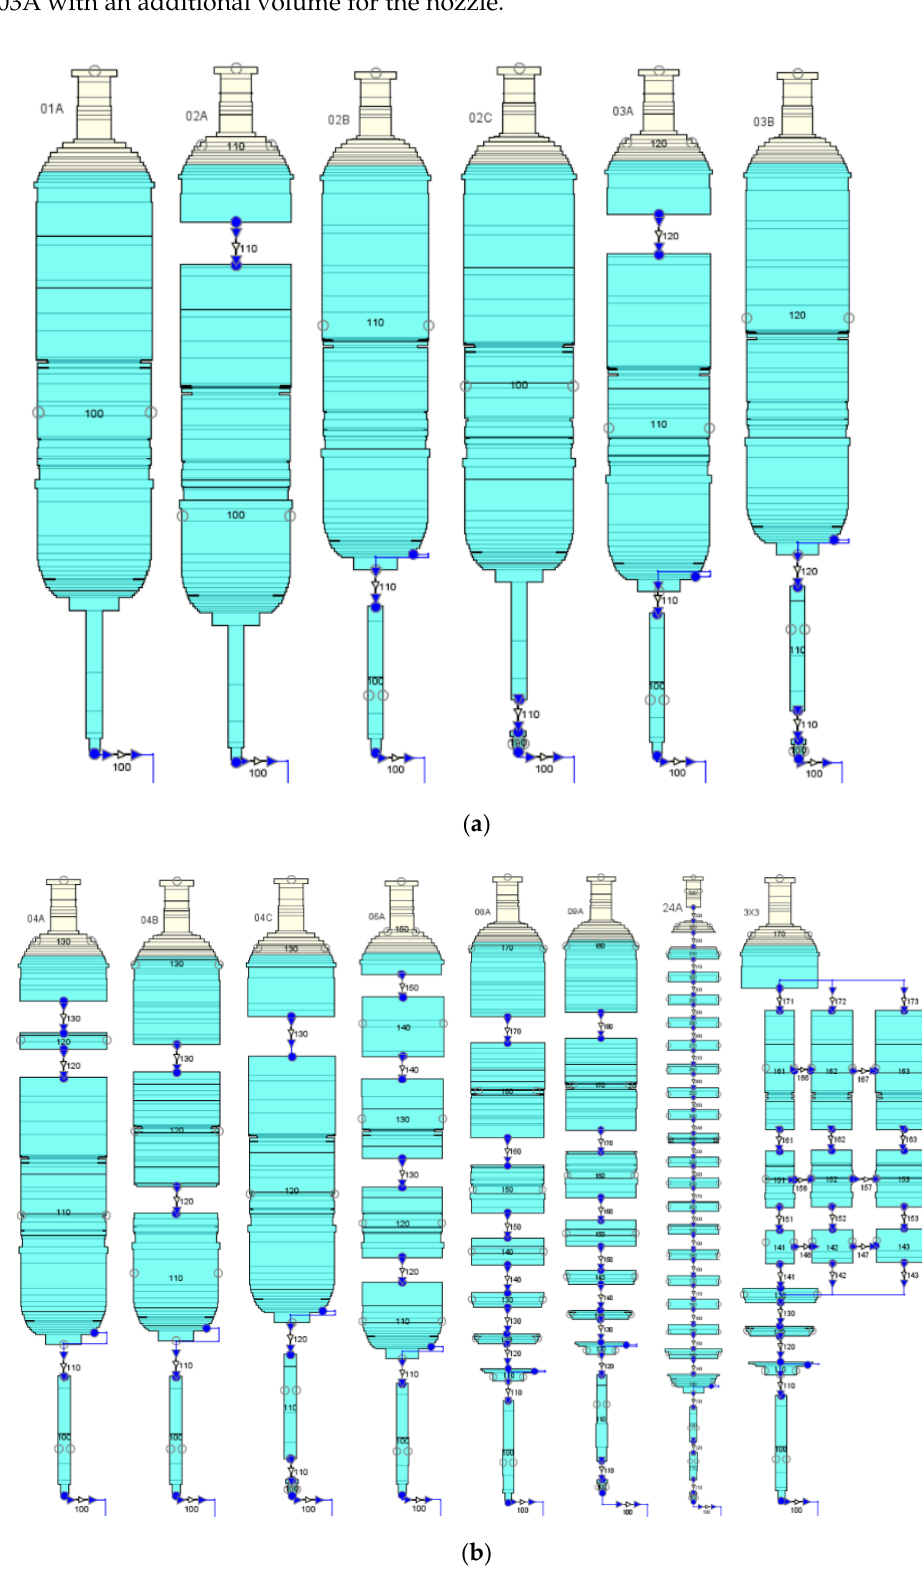
Figure 1. Marviken MELCOR nodalizations: ( a ) basic models and ( b ) complex models.